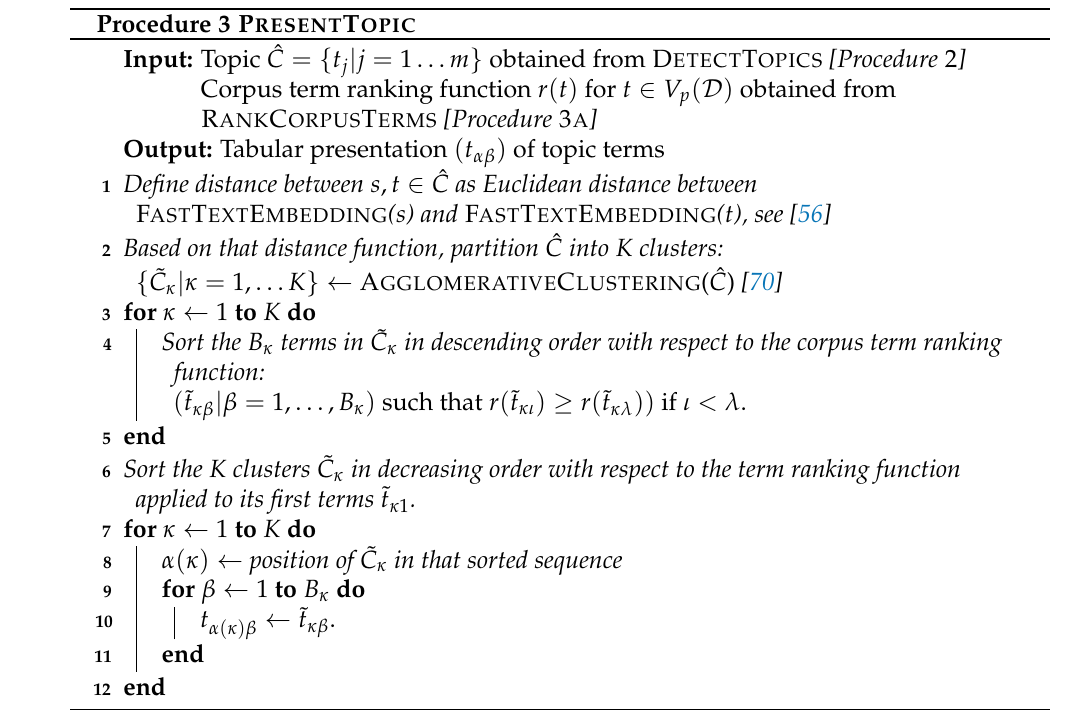
Procedure 3 P RESENT T